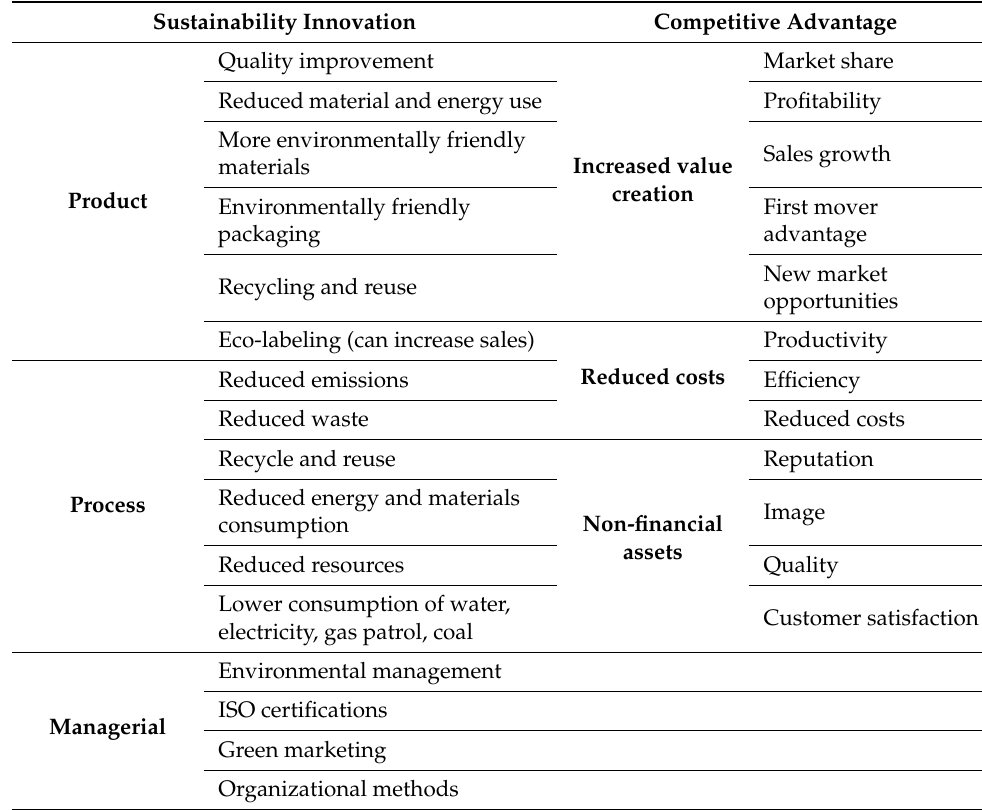
Table 1. Sustainability innovations and their competitiveness factors. Source: based on Hermunds- dottir and Aspelund (2020), edited by the